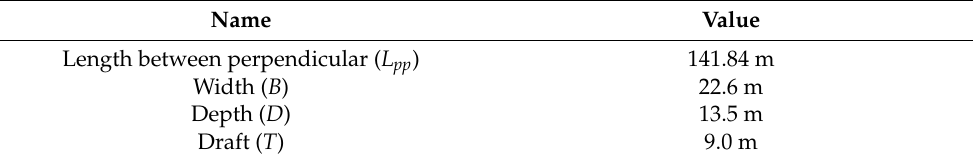
Figure 3. Ship model of semi bow. ( a ) Front view, ( b ) Top view and side view. Table 4. Ship parameters of semi bow.